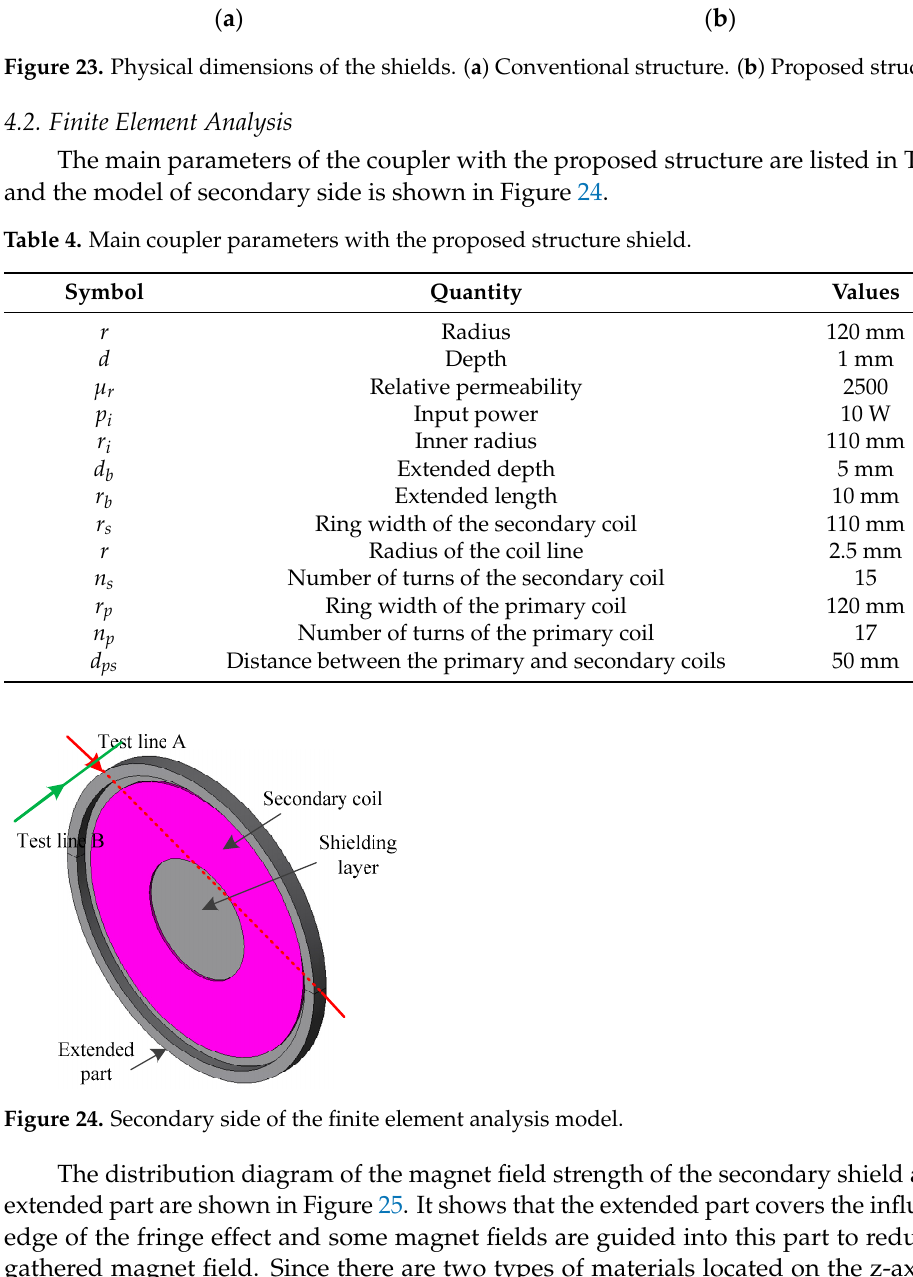
( b ) Figure 25. Distribution diagrams of magnetic field strength for the proposed structure. ( a ) Sec- ondary shield. ( b ) Extended part. –300